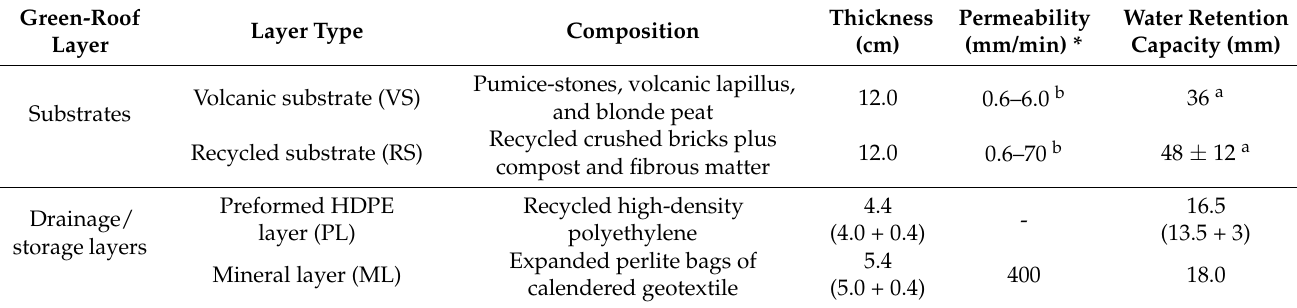
Table 1. Main characteristics of the tested materials used to assemble the green-roof microcosms.